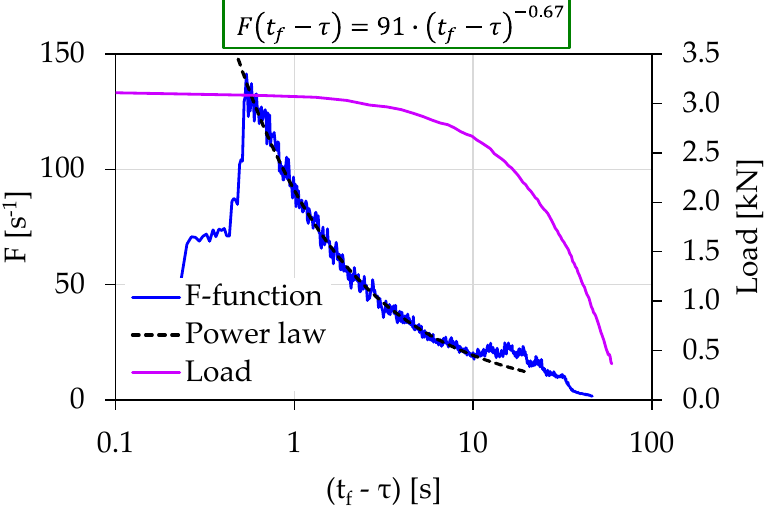
Figure 13. The temporal evolution of the F -function in juxtaposition to the load applied for the experiment Exp-HR in terms of the “time-to-failure” parameter.